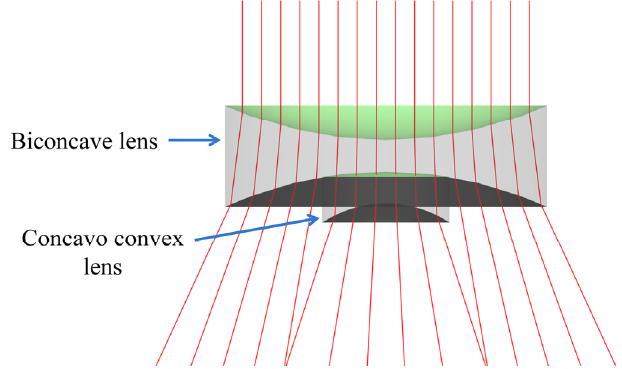
Figure 3. Behavior of the incident light on the diffuser